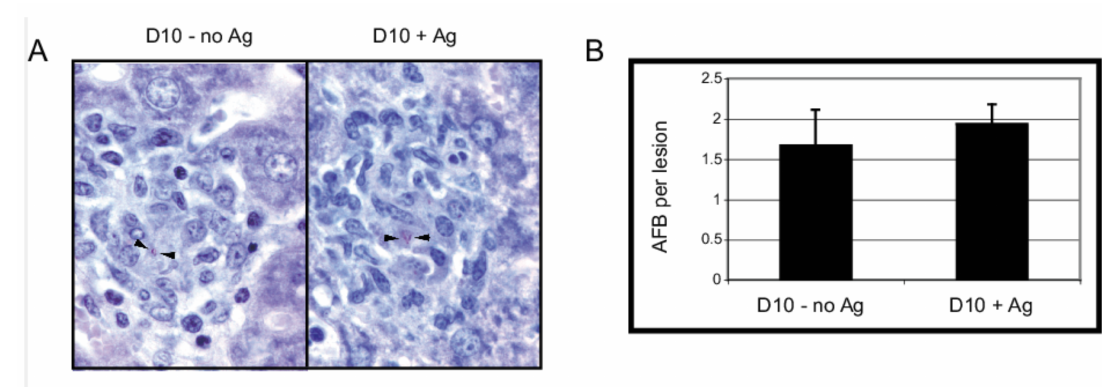
Figure 6. Immunization with CA does not result in dissemination or loss of bacterial control. ( A ), Formalin fixed liver tissue from nonactivated and activated mice was stained by the Ziehl–Neelsen method for acid-fast bacilli (arrows). ( B ), Number of acid-fast bacilli were counted microscopically at 1000 × total magnification. Error bars represent standard error of the mean (SEM). Note that no bacteria were detected outside of lesions. Data representative of three independent experiments with 2–4 mice per